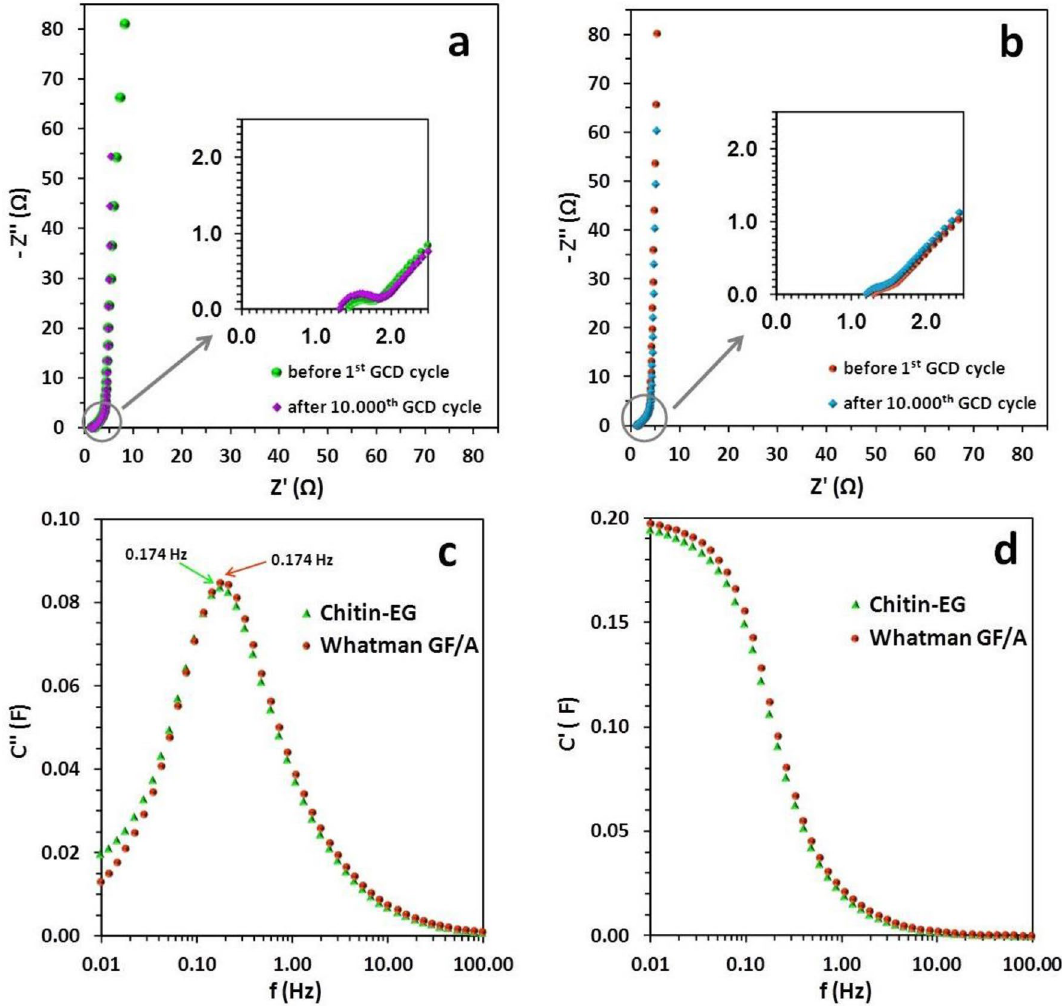
Figure 7. AC impedance spectra for capacitors with ( a ) chitin–EG hydrogel and ( b ) Whatman GF/A glass fiber separator. Evaluation of ( c ) the imaginary part of capacitance (C ′′ ) with characteristic frequencies and ( d ) the real part of capacitance (C ′ ) vs. frequency (on a logarithmic Figure 8a,b show cyclic voltammograms at different scan rates (from 2 to 100 mV s −1 ) recorded for the chi- tin–EG capacitor and for the Whatman GF/A reference cell. The shape of the CV curves for both tested EDLC cells can be described as nearly rectangular, indicating good charge propagation (up to 10 mV s −1 ). The voltam- mograms show no significant deviations (such as redox peaks) in the full spectrum of scan rates used, which may be interpreted as a lack of faradaic capacitance within the examined EDLC cells. Thus, the assembled test